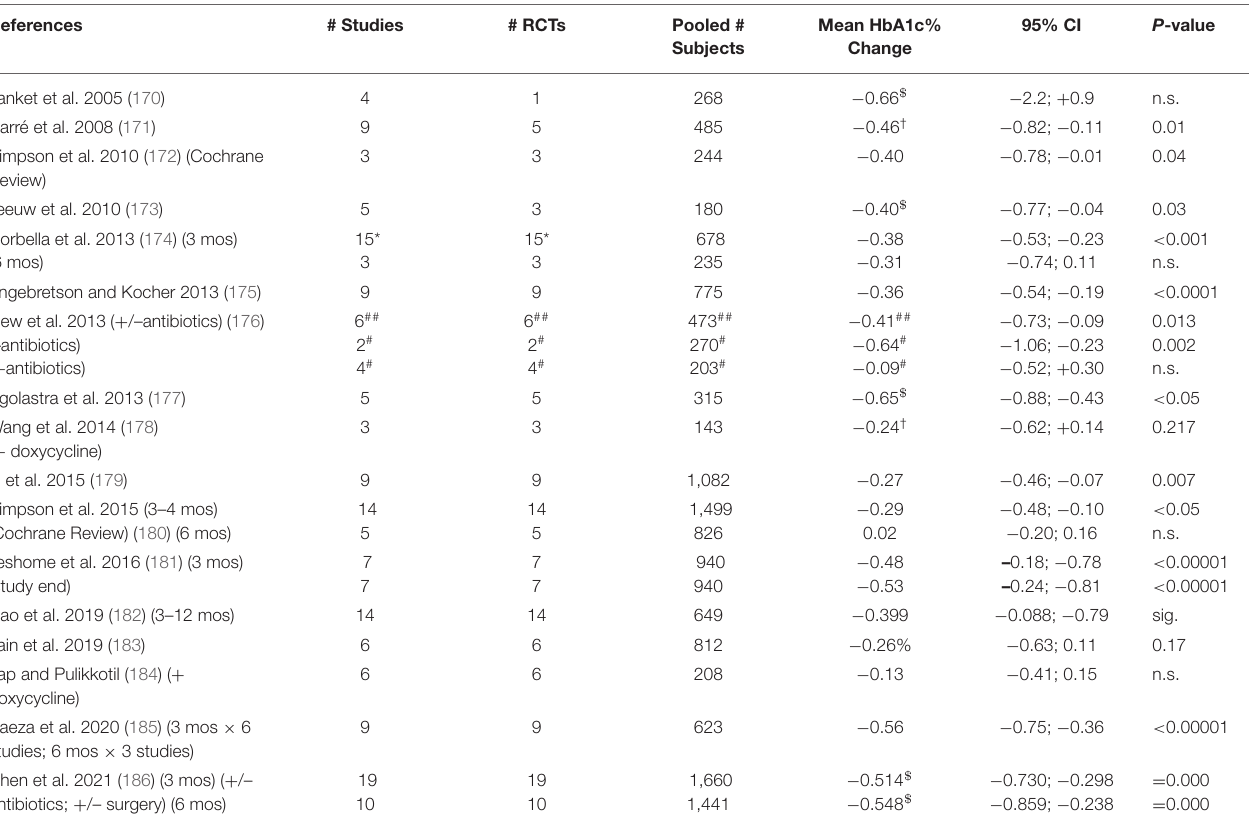
TABLE 1 | Effect of non-surgical periodontal treatment (scaling, root planing, and oral hygiene instruction) (NSPT) on glycated hemoglobin (HbA1c) level in type 2 diabetes (T2DM) 3 and 6 months post-intervention: